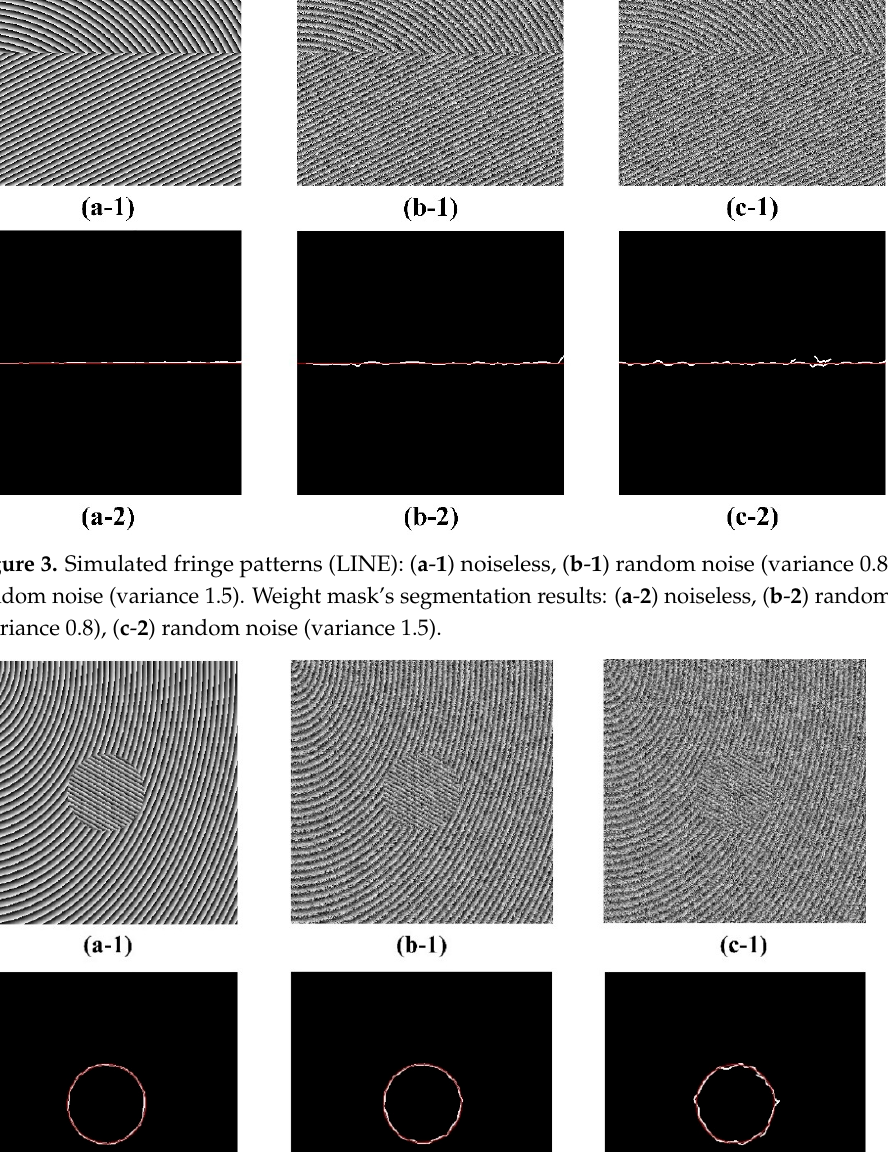
Table 2. SMEs of five algorithms for LINE and CIRCLE patterns (variance 1.5). identified boundaries and red lines denoting the ground truth. Quantitatively, for fringe patterns with random noise having variances of 0, 0.8, and 1.5, the SMEs were 0.2072, 1.9633, and 5.0673, respectively. The SMEs of CIRCLE pattern (variance 1.5) for the five algorithms are shown in the second row of Table 2.